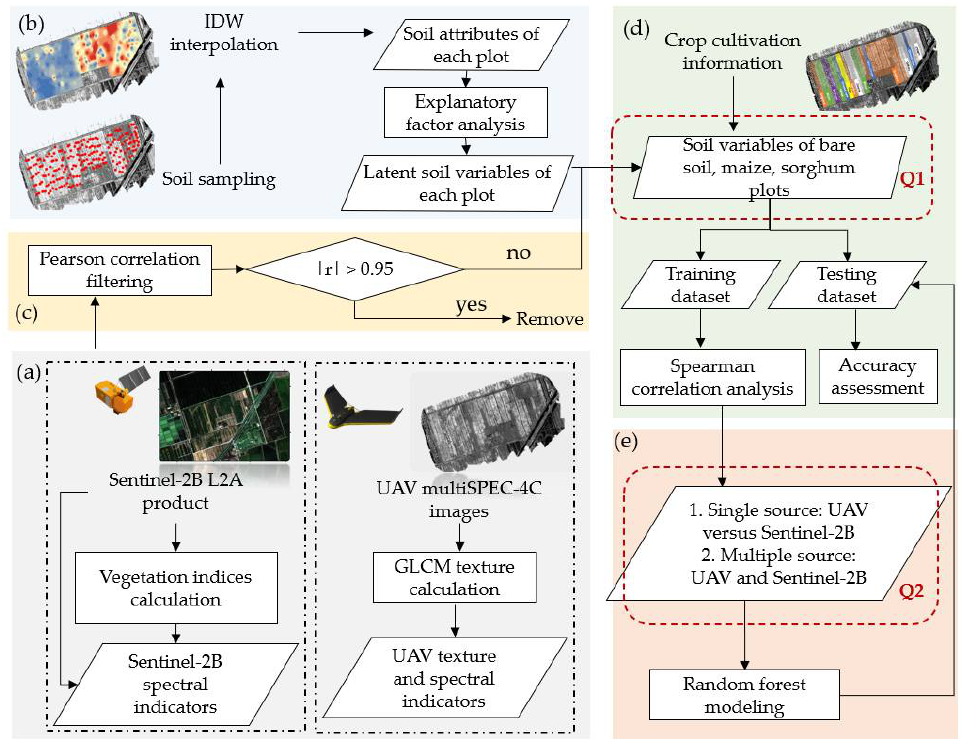
Figure 2. Brief workflow of this study: ( a ) generation of remote sensing indicators; ( b ) generation of soil latent variables; ( c ) filtering highly correlated remote sensing indicators; ( d ) diving into bare soil, sorghum, and maize regions; and ( e ) estimating soil variables of three regions using the random forest approach.